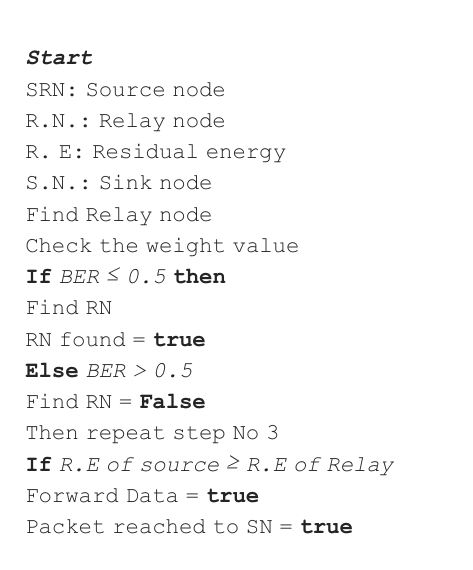
ALGORITHM 2. DATA TRANSFERRING THROUGH THE RELAY NODE